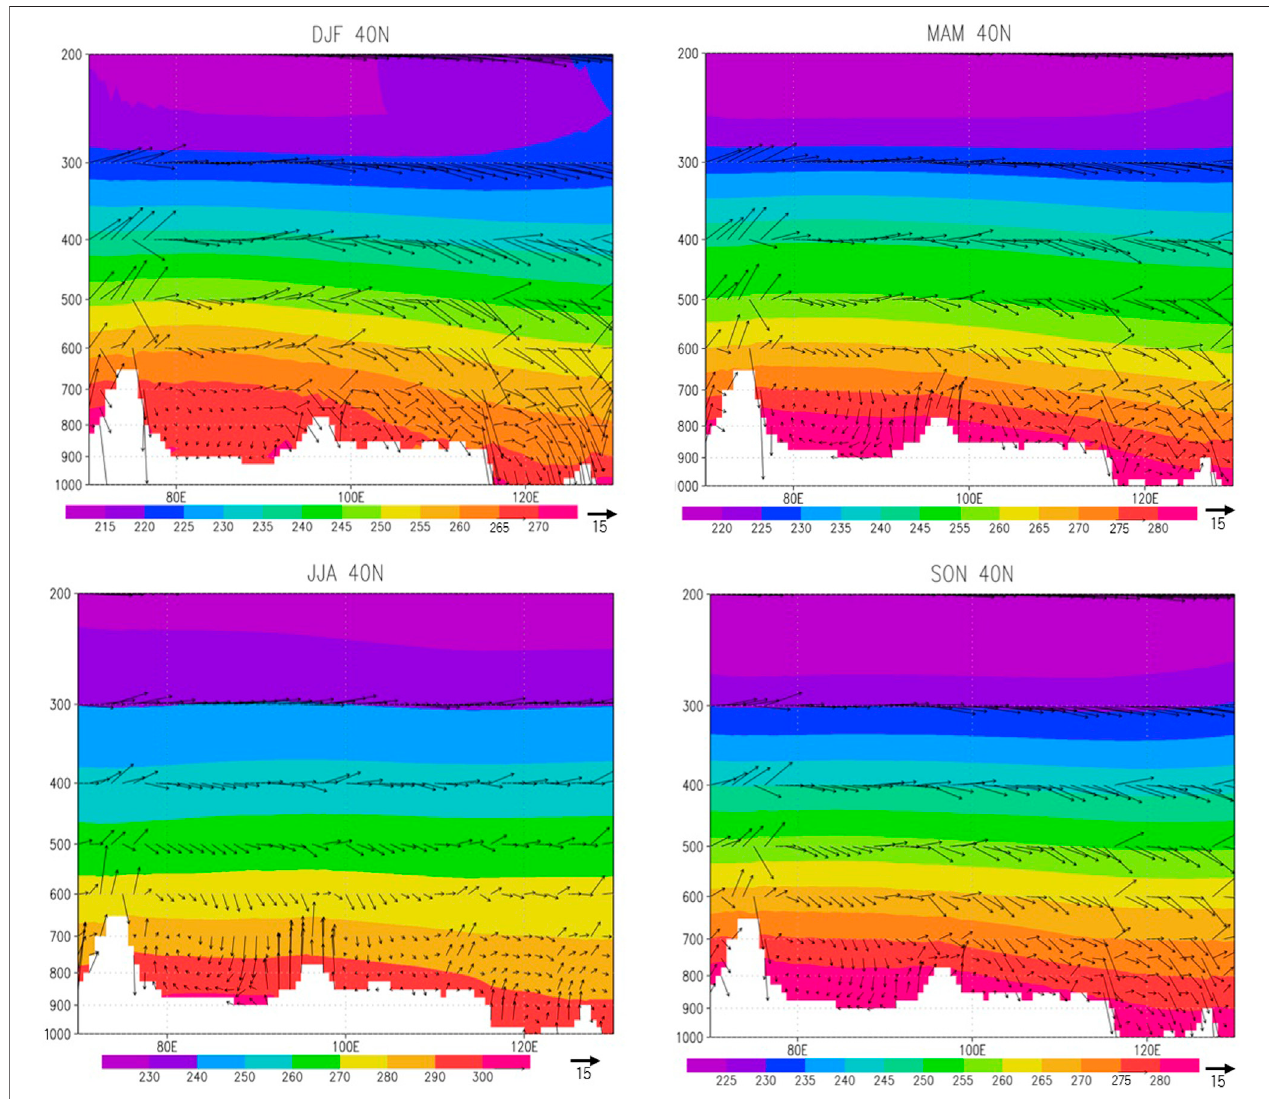
FIGURE9| Longitudepressurecrosssectionofwindvectors(horizontalunit:ms − 1 ,vectorunit: − 10 − 2 Pa s − 1 )andairtemperature(colored,unit:K)intheModern- Era Retrospective Analysis for Research and Applications, version 2 (MERRA2), dataset (Gelaro et al., 2017), along 40 ° N for climatological mean. DJF: winter; MAM: spring; JJA: summer; SON: fall.